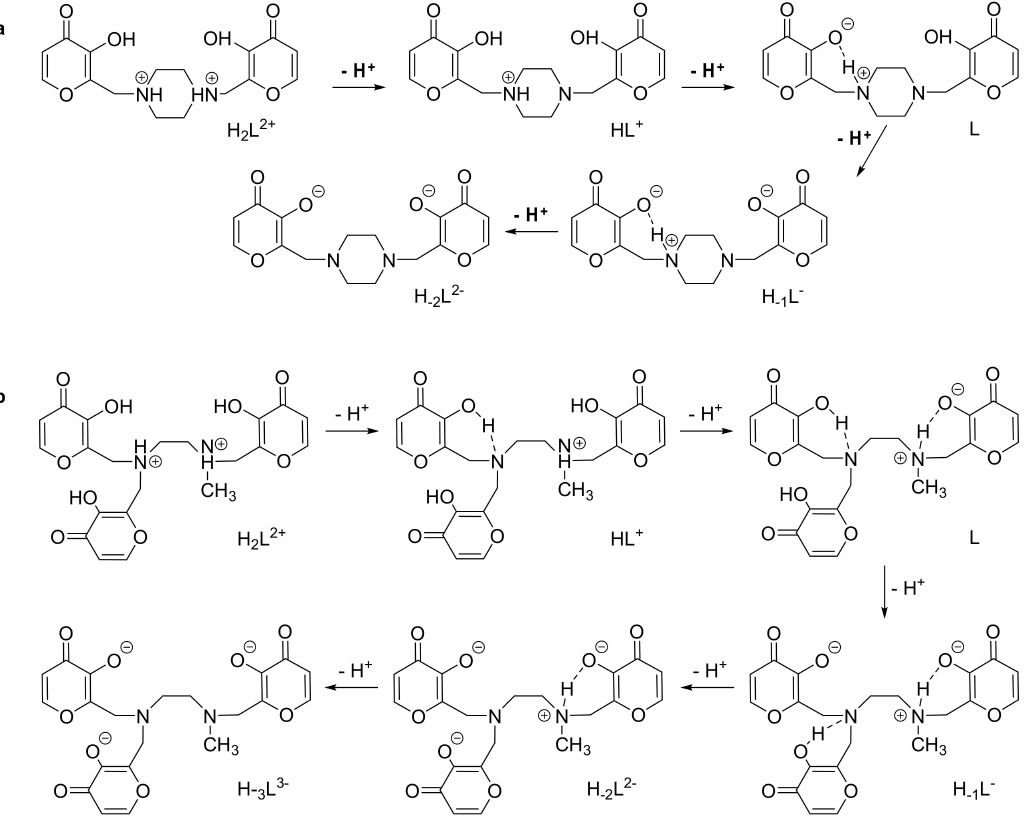
Figure 4. Proposed location of acidic hydrogen atoms in the protonated species of ( a ) L1 and ( b ) L2